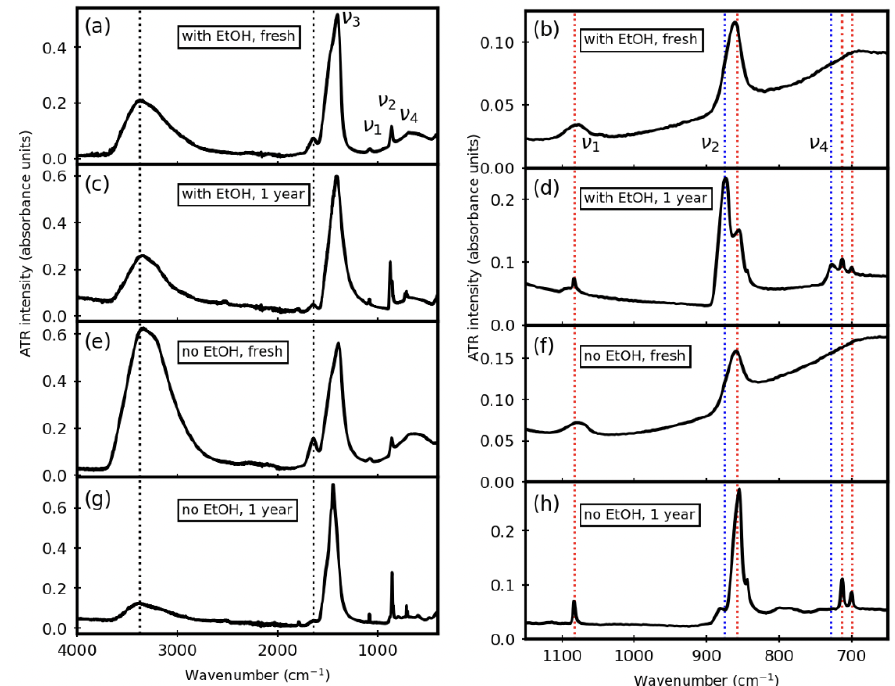
Figure 1. Representative ATR-FTIR spectra in the mid-IR range (400–4000 cm − 1 ) for synthesized ACC ( a , b ) with EtOH (fresh), ( c , d ) with EtOH (aged 1 yr), ( e , f ) without EtOH (fresh), and ( g , h ) without EtOH (aged 1 yr). The black dotted lines correspond to spectral features related to water (OH). The zoomed plots ( b , d , f , h ) emphasize the ν 1 region (1050–1100 cm − 1 ), ν 2 region (800–920 cm − 1 ), and ν 4 region (650–800 cm − 1 ). The red dotted lines indicate aragonite peak positions, and the blue dotted lines indicate dolomite peak